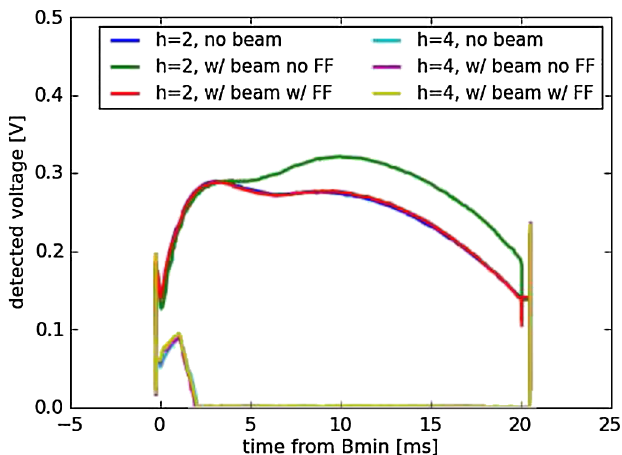
FIG. 18. A comparison of the driving rf voltage of no beam, without and with the feedforward. The cases of no beam and with feedforward are very close.